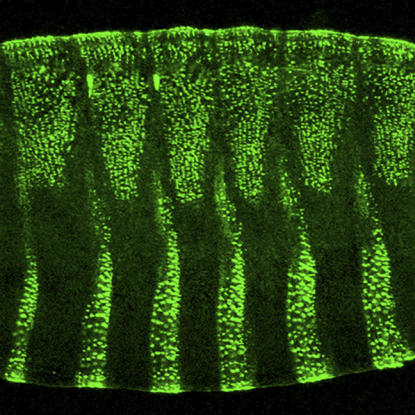
Cell shape remodeling: analyzing the function of genes specifically expressed in cellular extensions of Drosophila embryonic epidermis (green stain of a protein called Miniature).